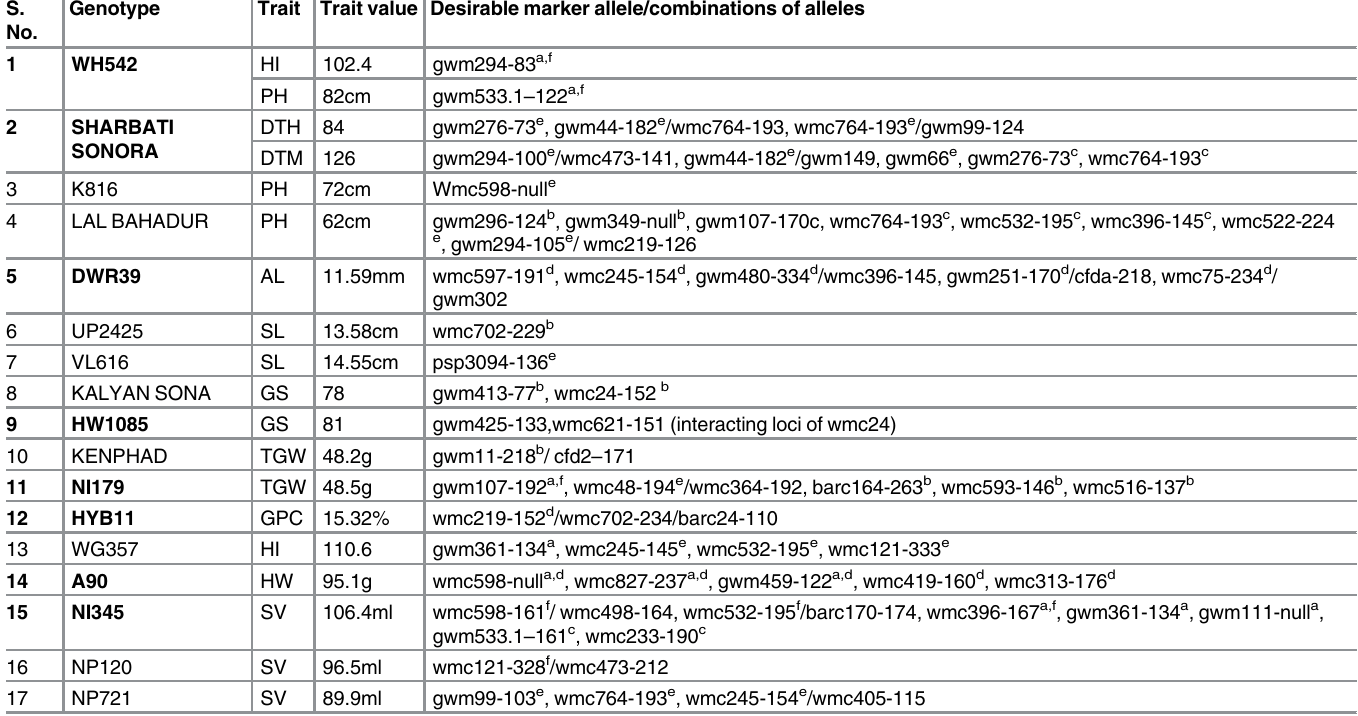
Table 8. A summary of the 17 superior genotypes and markers with desirable alleles associated with respective traits. Number given after bar (-) represents desirable allele size (in bp). Two markers, separated by “ / ” , are involved in epistatic interaction; and among these pairs of interacting markers, the first marker was identified by either one, two, or by all the three approaches (SLST, MLMM, MTMM). Eight genotypes considered more important are highlighted with bold. S. No.